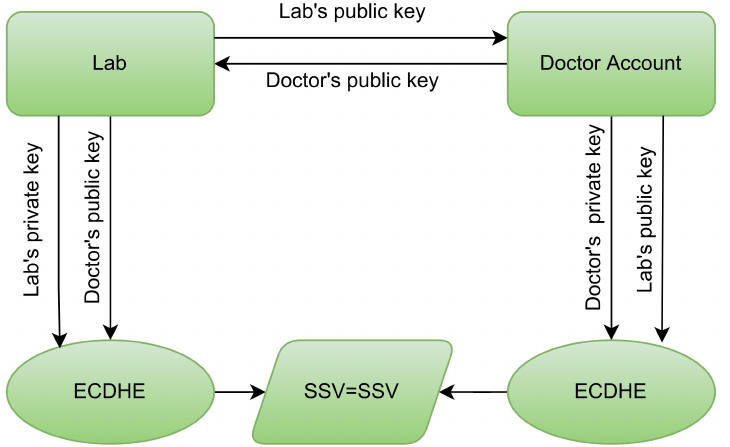
Figure 1. Public key